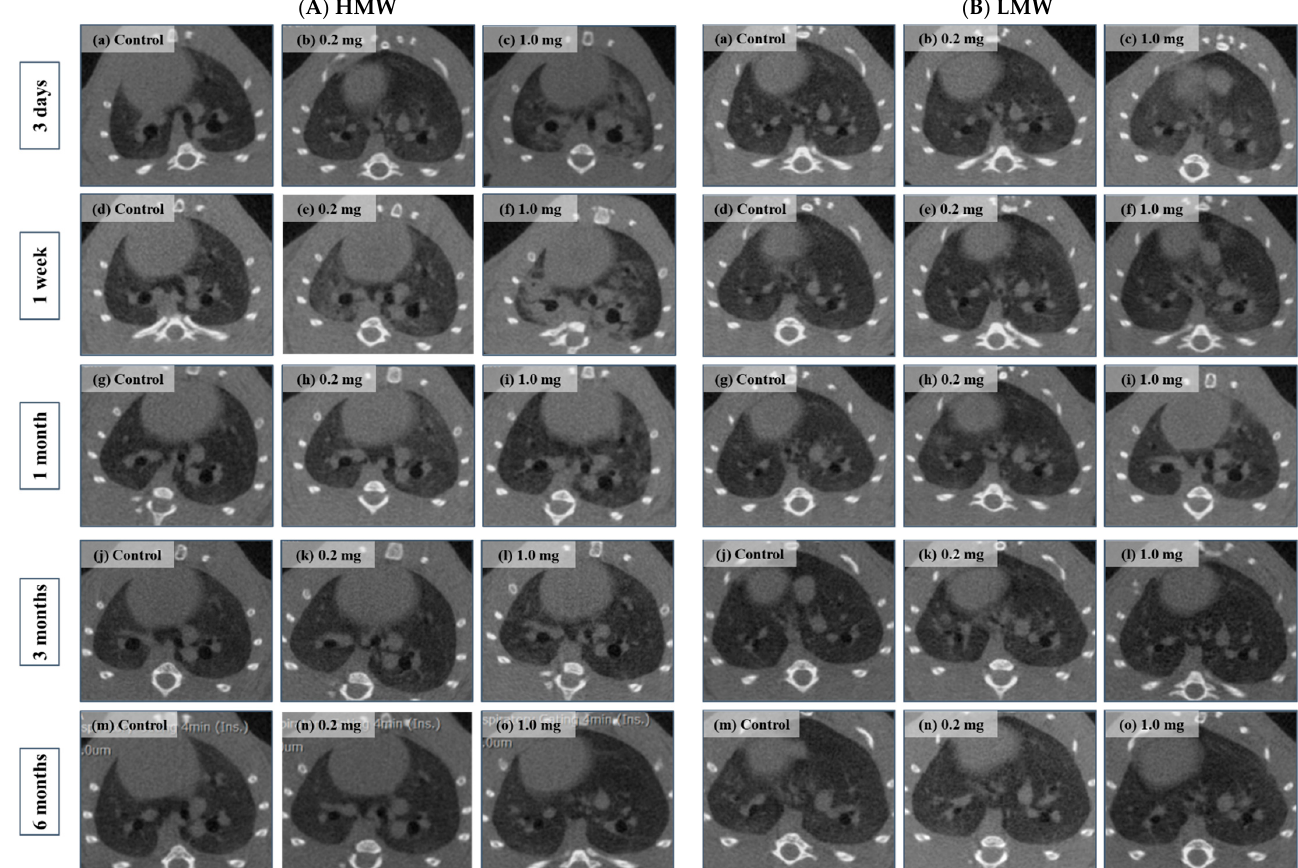
Figure 6. 3D micro-CT imaging after intratracheal instillation. ( A ) HMW PAA-exposure group